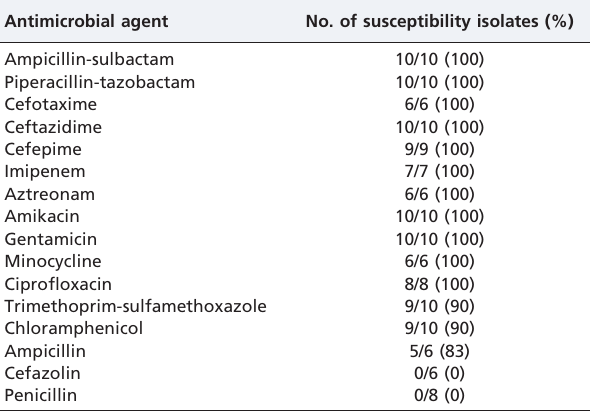
Table 2 - Antimicrobial susceptibility data for the Shewanellla